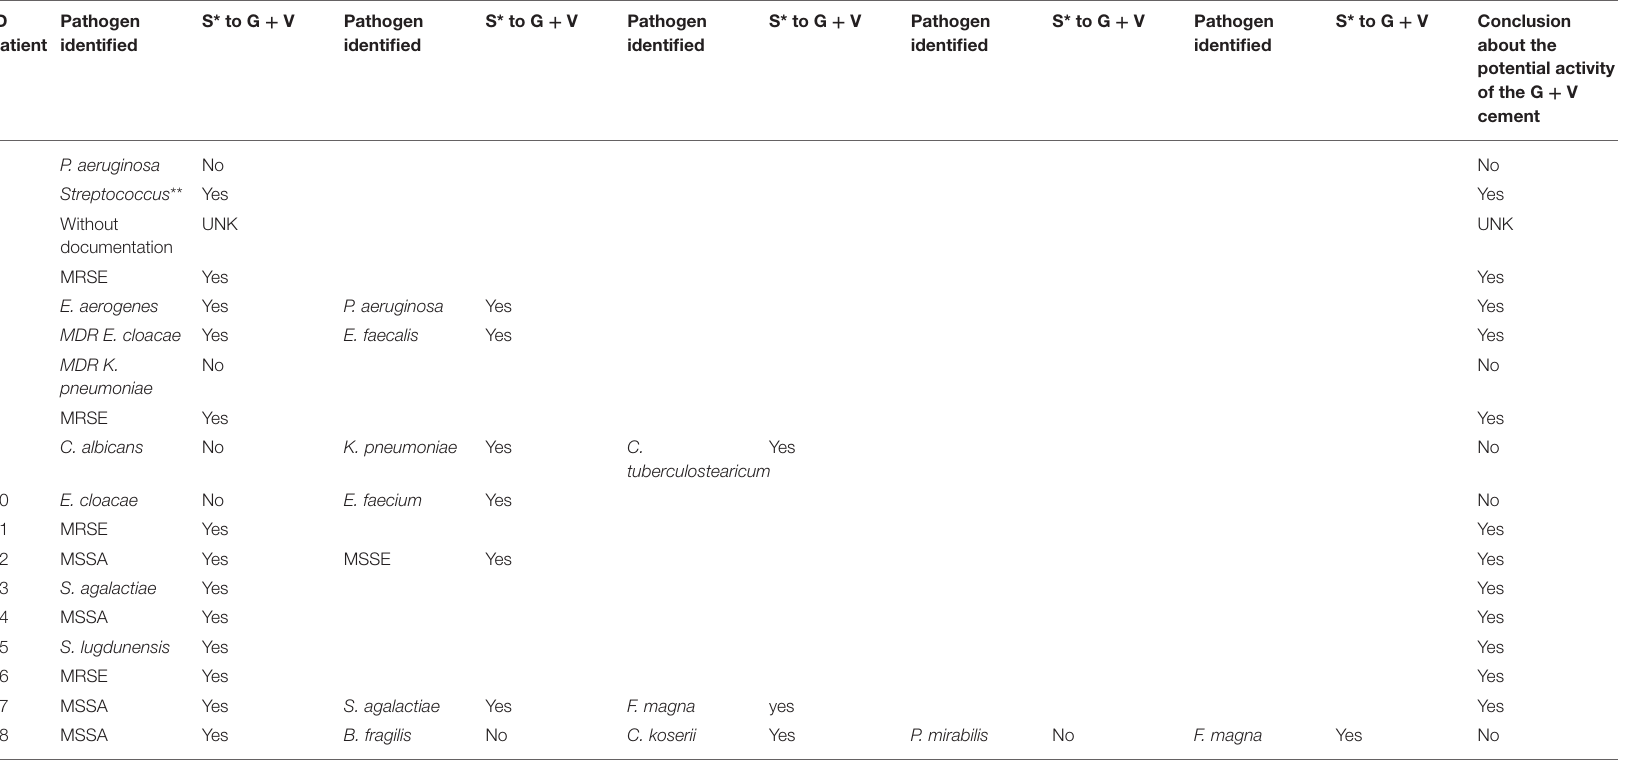
TABLE 5 | Description of the pathogens and their susceptibility to gentamicin + vancomycin combination for the 18 patients with a failure after prosthesis reimplantation. ID Pathogen patient